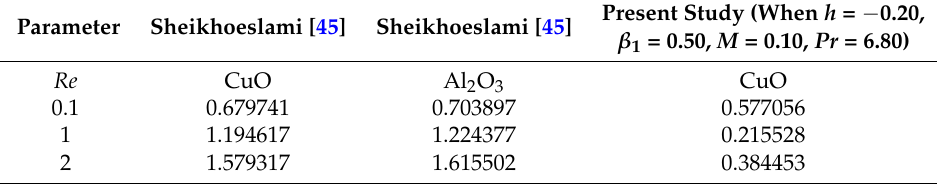
Table 5. Comparison of the effects of different kinds of nanoparticles on skin friction coefficient ( C f ) as a function of Reynolds number Re when φ = 0.04.